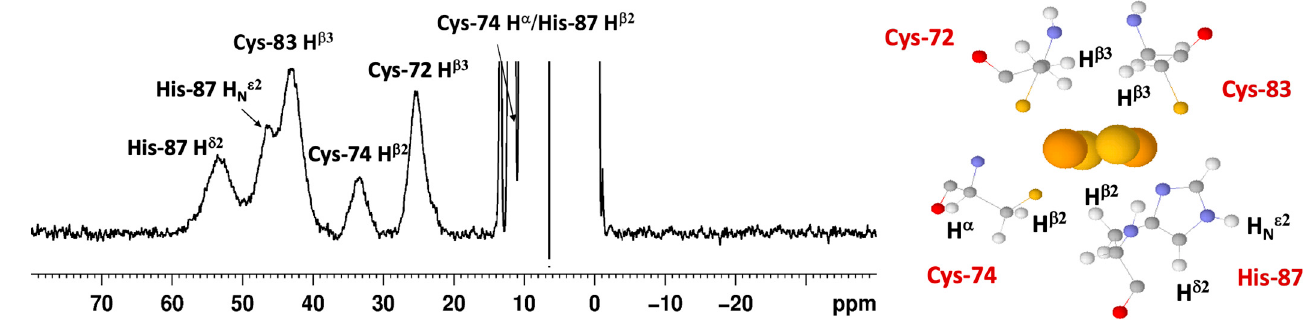
Figure 3. Paramagnetic 1 H NMR spectra of [2Fe-2S] 2+ -containing proteins: ( a ) ferredoxin from red algae [85]; ( b ) human glutaredoxin-5 [56]; ( c ) human anamorsin [91]; ( d ) human ISCA2 [83].